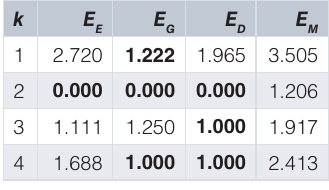
Table 3. Average error size (when wrong) over n = 200 runs.